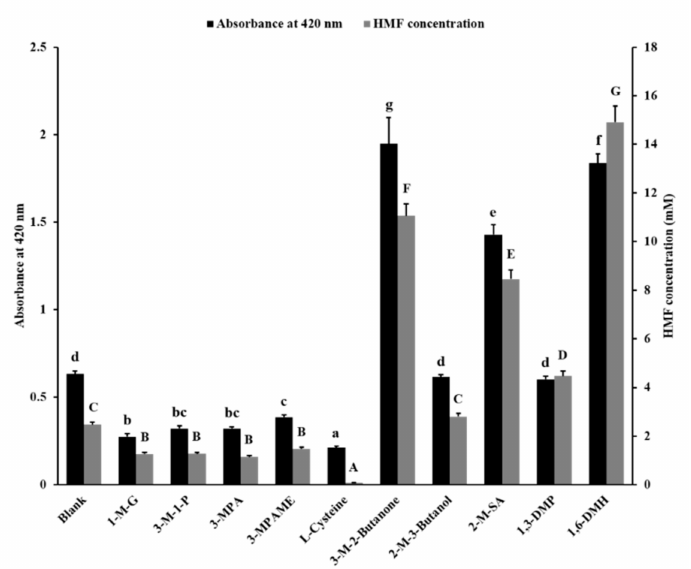
Figure 1. Inhibitory effect of sulfhydryl compounds on Maillard browning and 5-hydroxymethy- lfurfural (HMF) concentration in the fructose–glutamic acid model system. Different letters indicate a significant difference, p < 0.05. 1-M-G, 1-mercaptoglycerol; 3-M-1-P, 3-mercapto-1-propanol; 3- MPA, 3-mercaptopropanoic acid; 3-MPAME, 3-mercaptopropionic acid methyl ester; L-cysteine, (2R)-2-amino-3-mercaptopropanoic acid; 3-M-2-Butanone, 3-mercapto-2-butanone; 2-M-3-Butanol, 2-mercapto-3-butanol; 2-M-SA, 2-mercaptosuccinic acid; 1,3-DMP, 1,3-dimercaptopropane; 1,6-DMH,